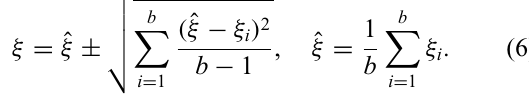
). (b) For the lattice 2D